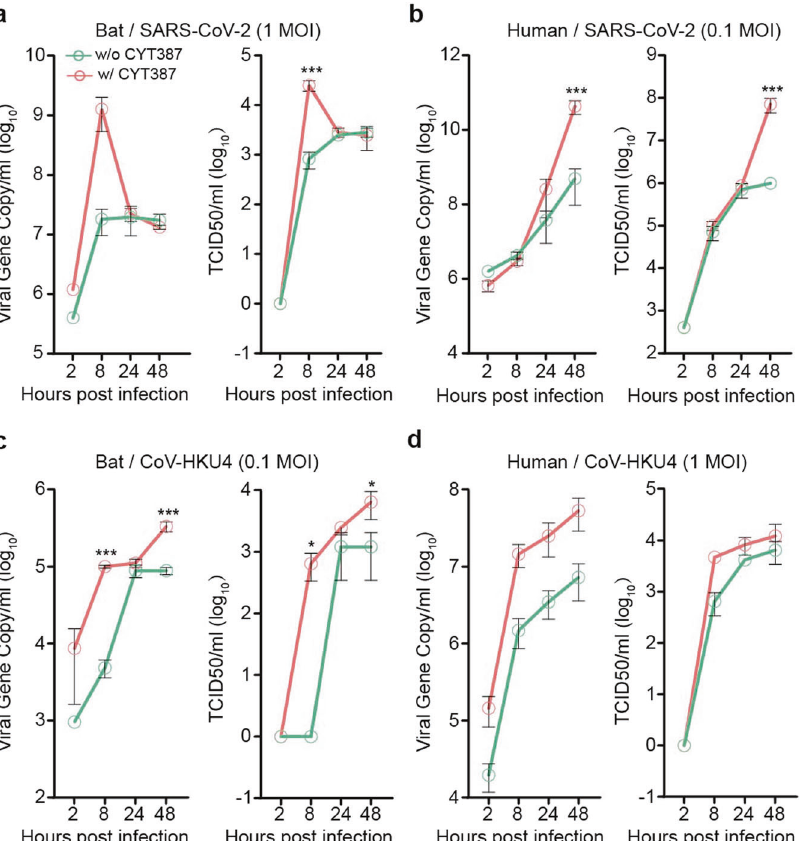
Fig. 5 CYT387 treatment enhanced viral replication in bat intestinal organoids in the early stage of viral growth. Bat and human intestinal organoids were pretreated with 1 μ g/ml CYT387 or DMSO overnight. After inoculation with WT SARS-CoV-2 or CoV-HKU4, the pretreated bat and human organoids were incubated with 1 μ g/ml CYT387 or DMSO. At indicated time points after infection, cell-free media were collected and subjected to viral load detection and viral titration. Data represent mean and s.d. in each organoid line, n = 3. Ordinary one-way